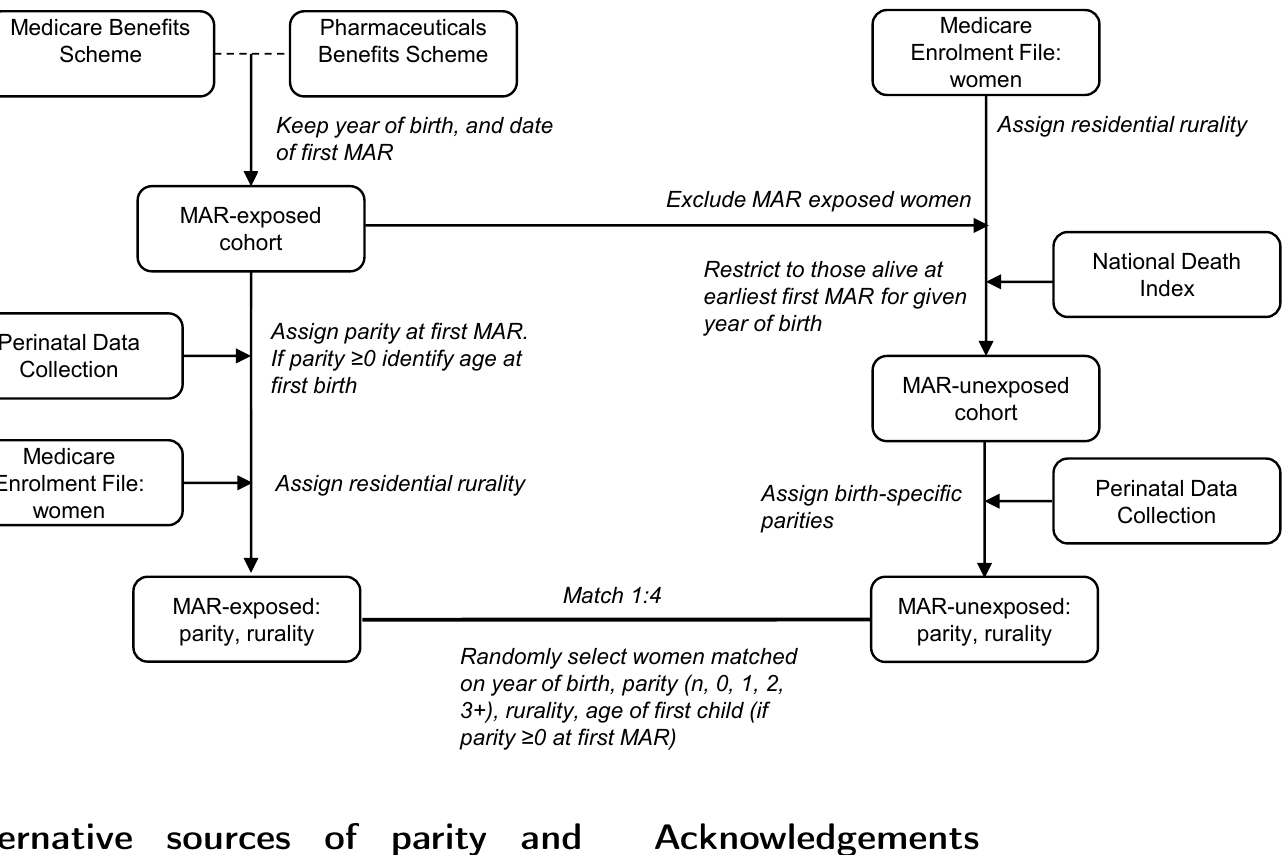
Figure 1: Overview of data flows to construct the MAR-exposed women and unexposed (non-MAR) women